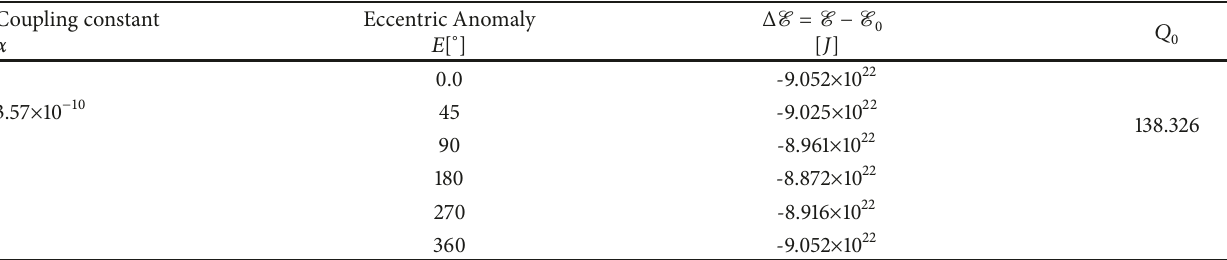
Table 3: Tabulation of parameters relating to the ratio of the mediating graviton mass at perihelion for a sun like star as is “felt” from the orbiting secondary i.e. Mercury for 𝛼 = 3.57 × 10 −10 and 𝜆 = 4.937 × 10 15 m and for various values of the eccentric anomaly.